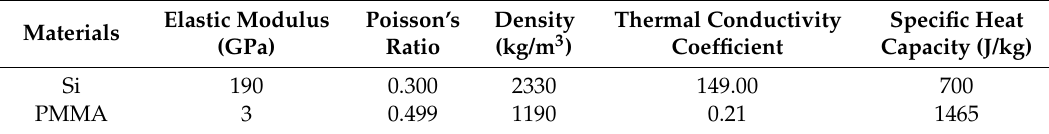
Table 1. Material properties for a Si mold and PMMA